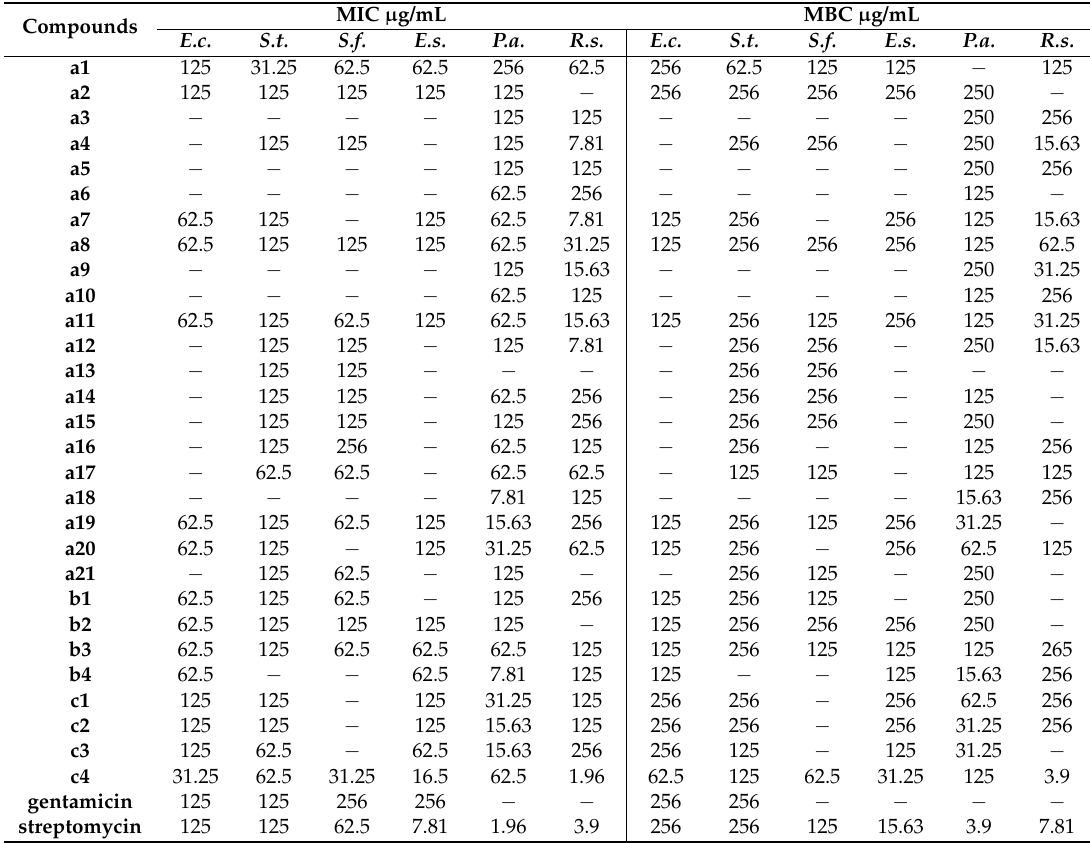
Table 2. Antibacterial activity of calycanthaceous alkaloids derivatives against E. coli , S. typhimurium